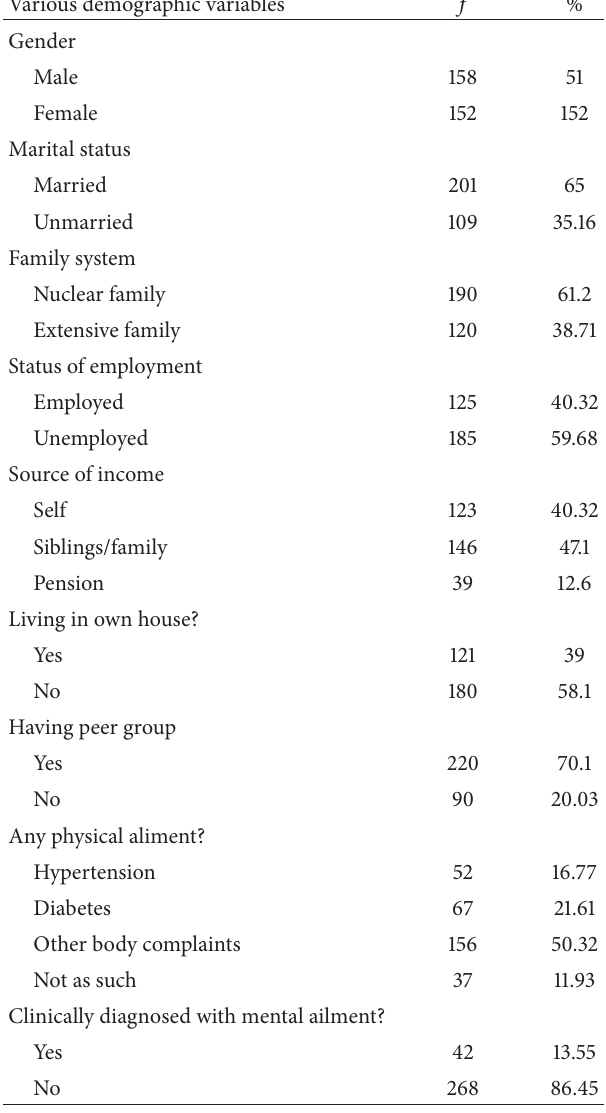
Table 1: Frequency of various demographic